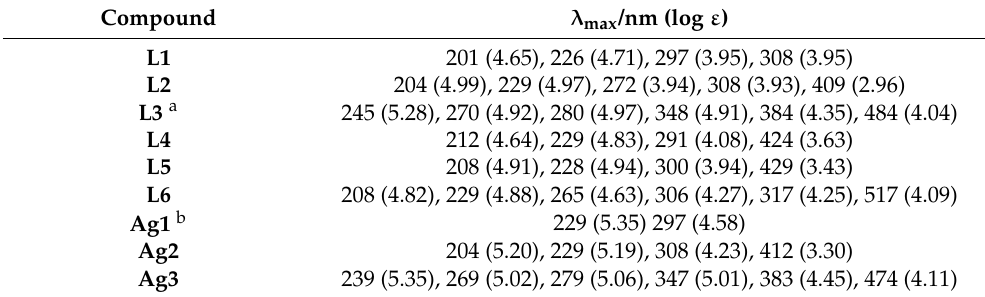
Table 1. UV-vis absorption data of the prepared BIAN ligands L1 – L6 and corresponding Ag(I) bis-BIAN complexes Ag1 – Ag6 in acetonitrile (except for L3 and Ag1 ).